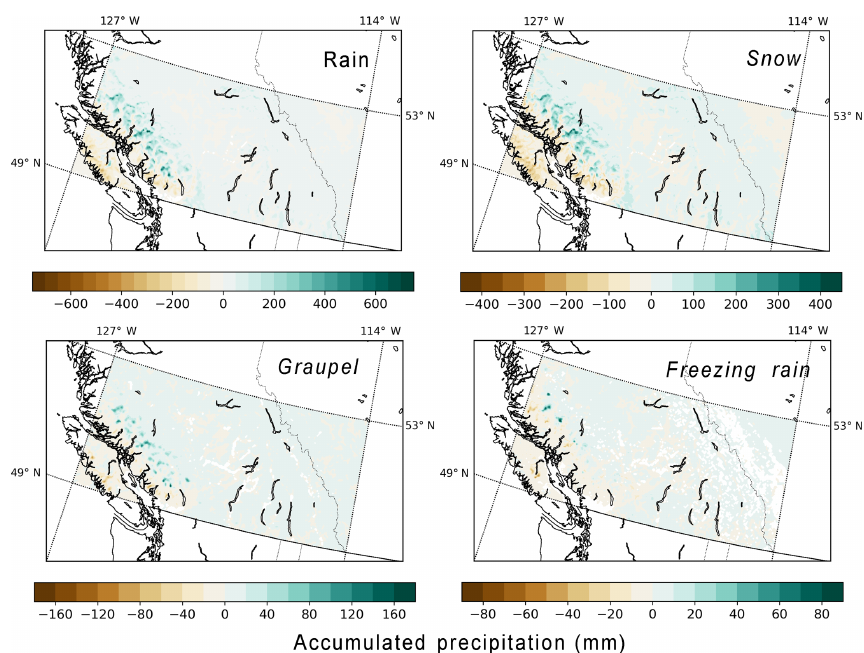
Figure 7. Transition region accumulated precipitation difference for snow, graupel, freezing rain and rain (PGW–CTRL) over the January– April 2010